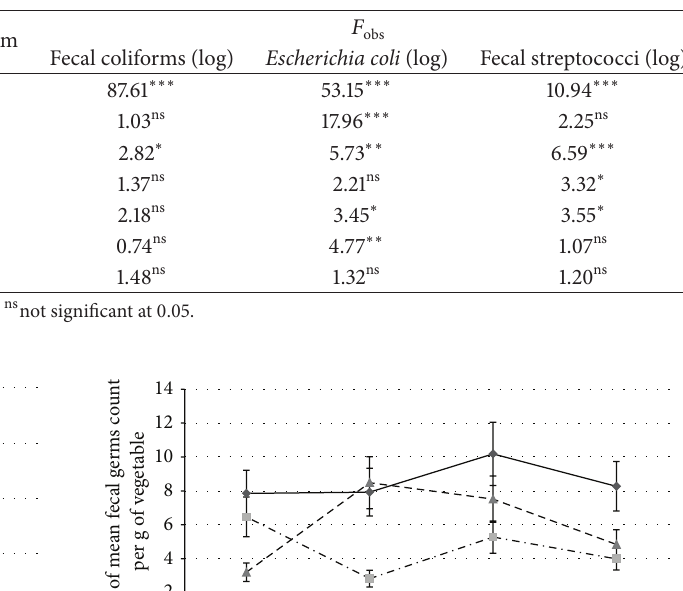
Table 3: Analysis of variance onrepeated measures: Fisher values illustrating the effects of growing period, fertilization modality, vegetable crop, and site on the fecal bacteria populations in vegetables (coastal area of Benin, 2009-2010, 288 plots).